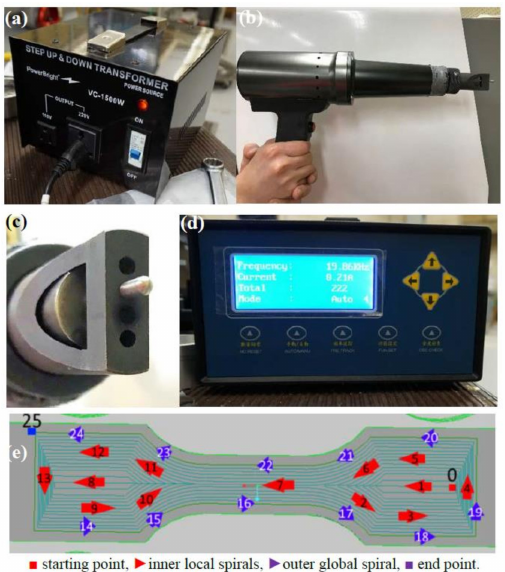
Figure 2. UIT system and application pattern. ( a ) Power supply unit; ( b ) side view of the UIT device; ( c ) front view of the UIT device showing impactor position; ( d ) ultrasonic generator; ( e ) schematic of treatment path.